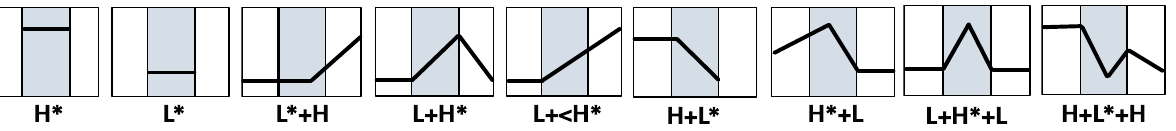
Figure 11. Schematic representation of pitch accents found in the data (Pešková 2020).